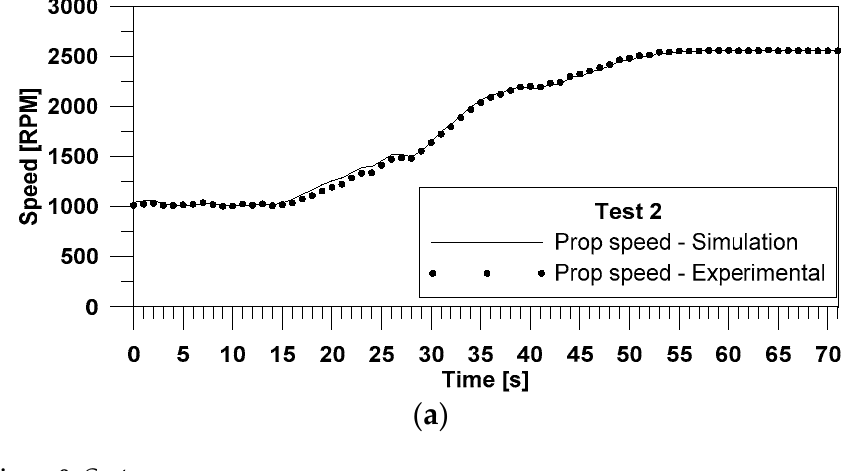
Figure 8. Test 1: calculated SLS, battery voltage and current. As in the previous case, the model replicated the experimental data. The model ICE throttle was handled by the PID controller and the EM throttle follows a predefined function. This function consists of three parts: